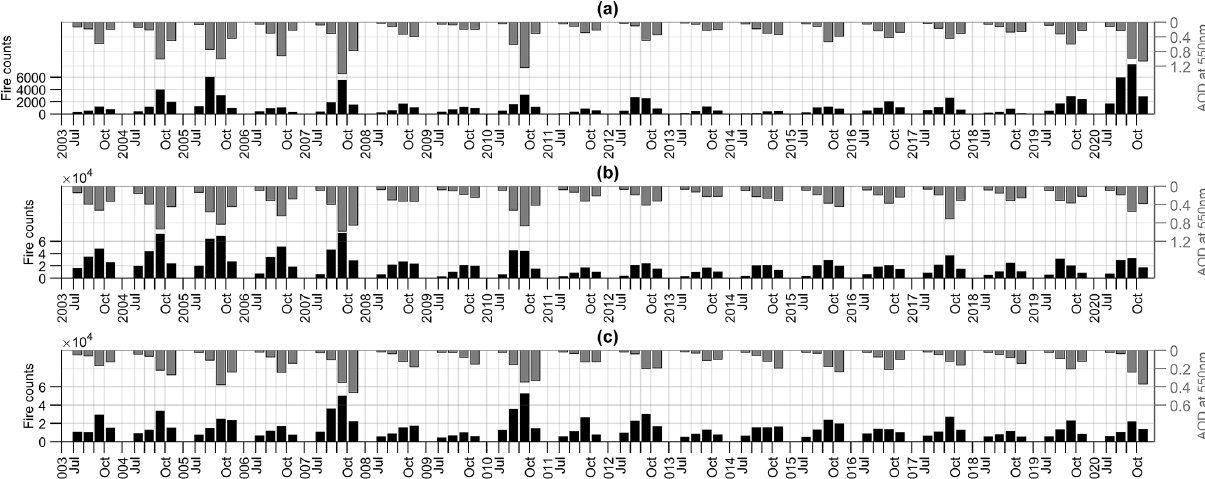
Figure 2. Monthly (from July to October) interannual evolution of fire counts (black) and aerosol optical depth at 550nm (gray) for the years from 2003 to 2020 for the (a) Pantanal, (b) Amazonia, and (c) Cerrado biomes.